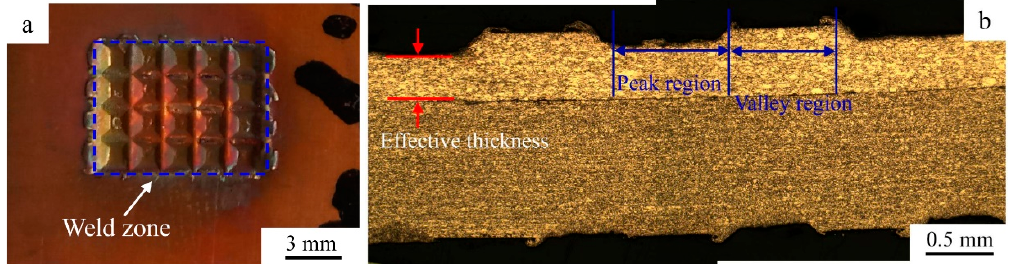
Figure 1. Diagrammatic drawings of the weld zone of Cu/Cu joint ( a ) and its partial cross section ( b )